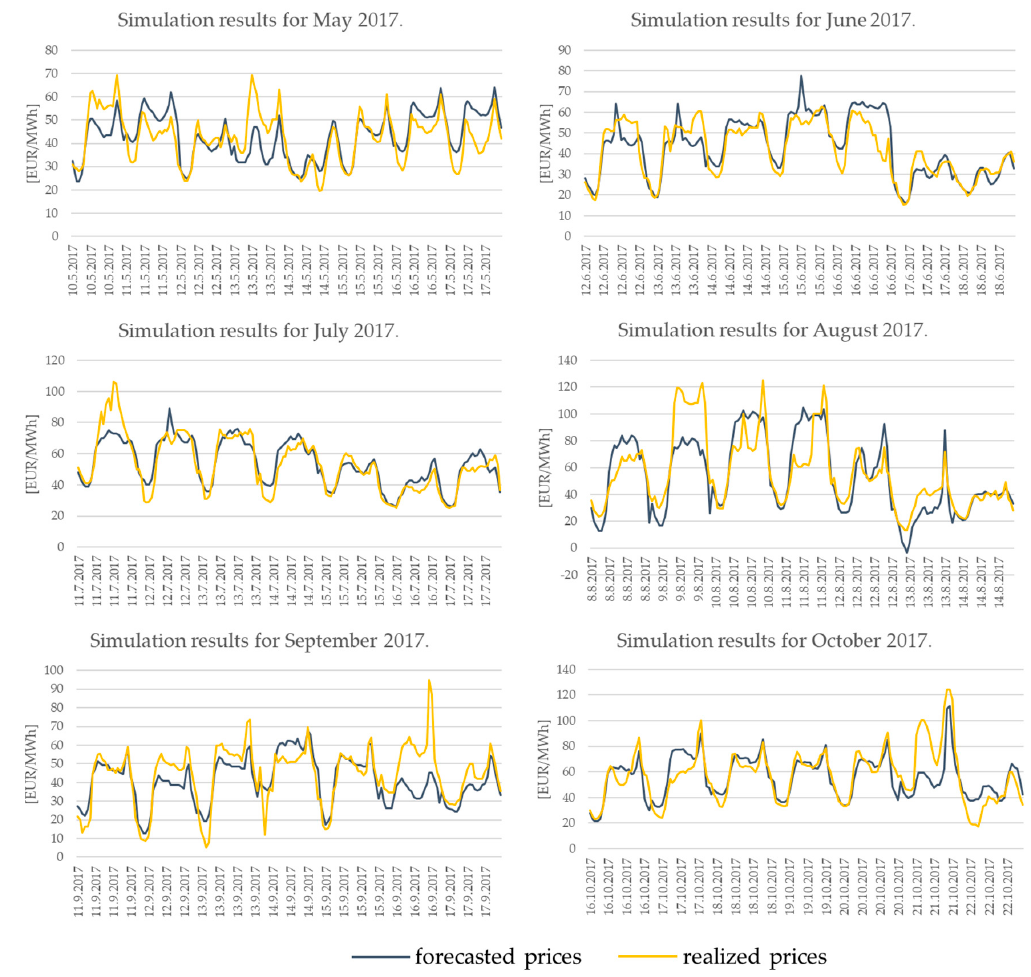
Figure 14. Forecasted and actually realized hourly prices in first forecasting interval for the period from May 2017 to October 2017.